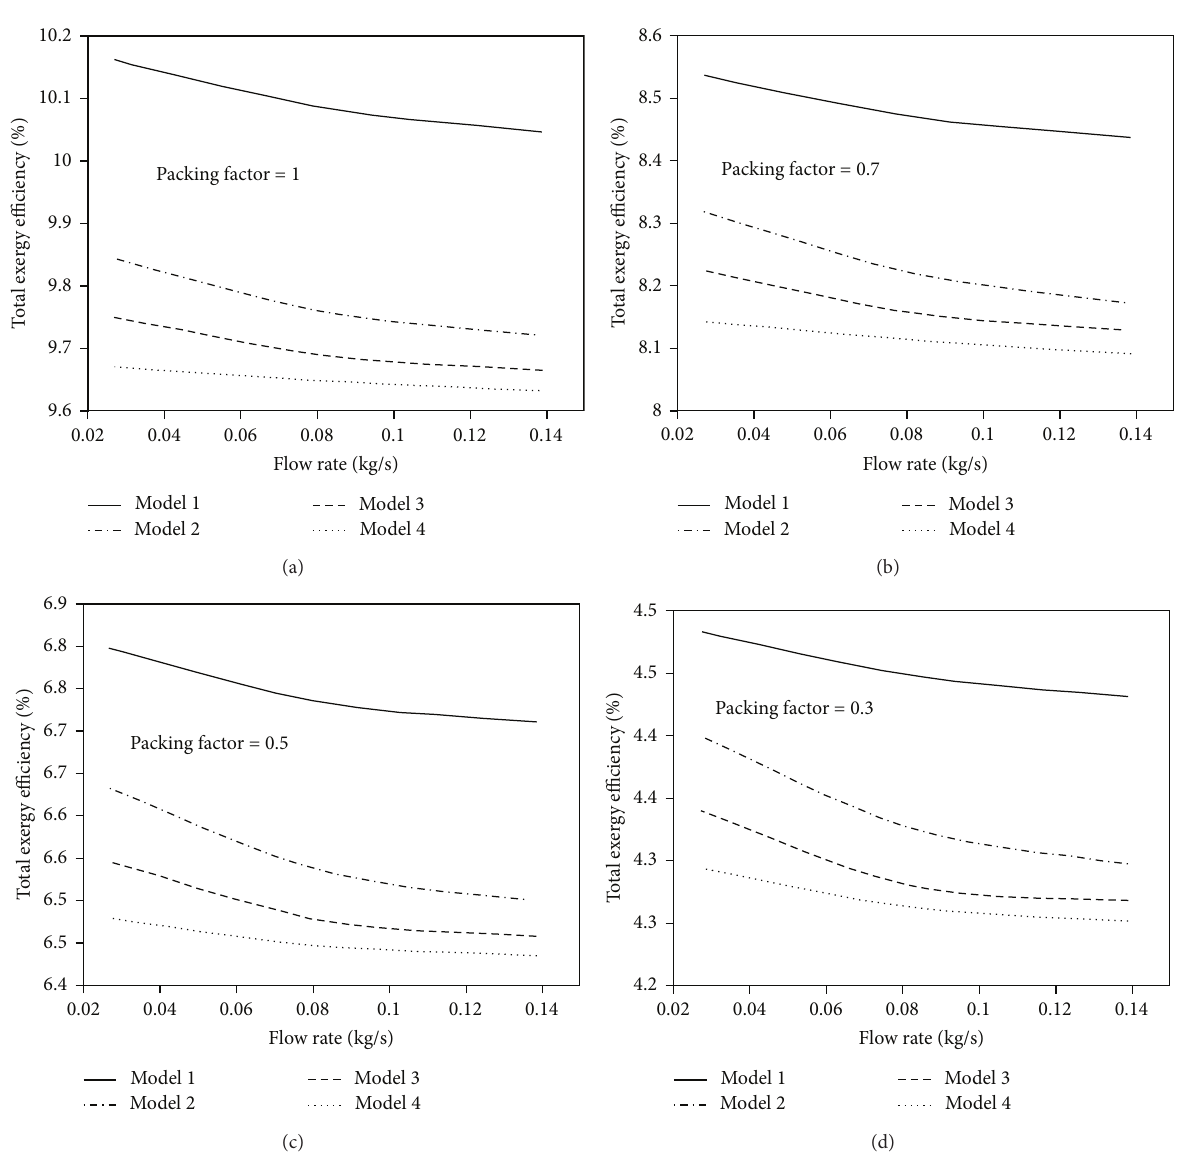
Figure 6: Total exergy efficiencies of the four models at different packing